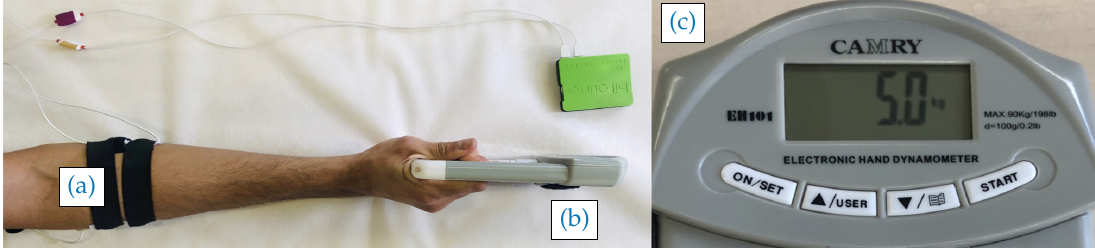
Figure 2. Experimental Setup: (a) the textile electrodes location; (b) the dynamometer (fixed to the table with tape) and SEMG data acquisition device (in green); and (c) the dynamometer value